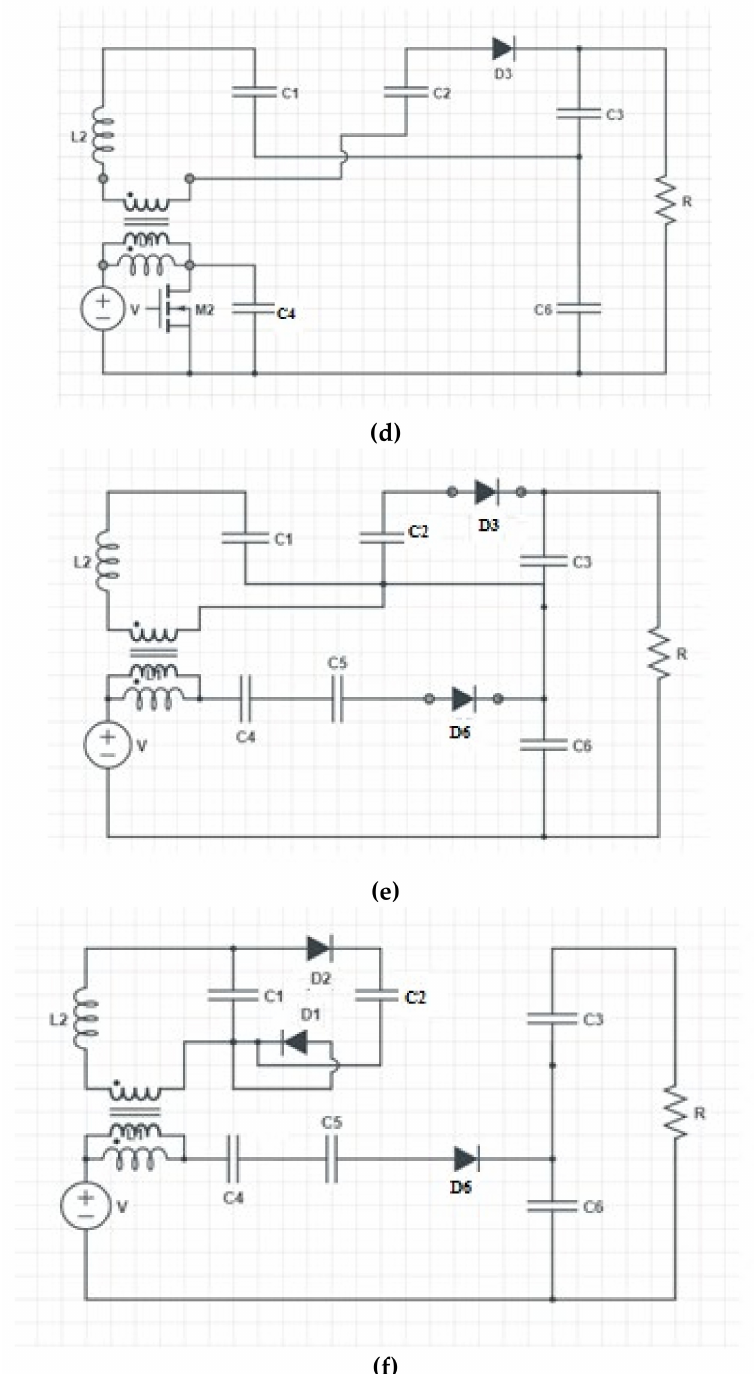
Figure 2. ( a ) Schematic diagram of proposed converter ( b ) Steady state waveforms ( c ) Mode 2 operation. ( d ) Mode 3 operation. ( e ) Mode 4 operation. ( f ) Mode 5 operation. Mode 5 (t 4 − t 5